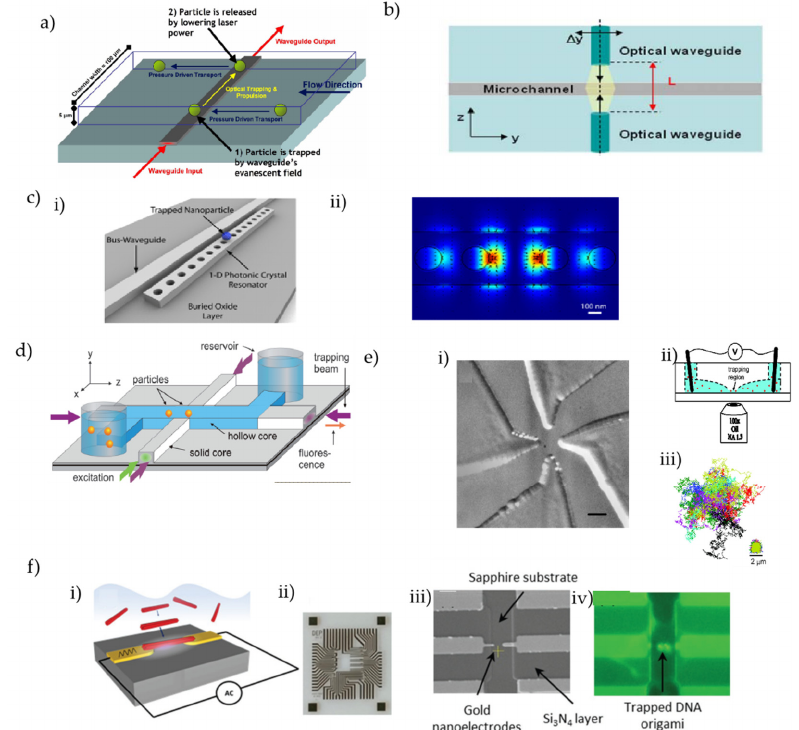
Figure 7. ( a ) Schematic of trapping experiment. The optical waveguide propulsion is perpendicular to the direction of the pressure-driven flow in the channel [333]. ( b ) Basic scheme of the optofluidic chip: the two waveguides emit counter-propagating Gaussian beams. The sample under testing flows into the microchannel [334]. ( c ) ( i ) 3D schematic of the one-dimensional photonic crystal resonator optical trapping architecture [337] ( ii ) 3D FEM simulation illustrating the strong field confinement and amplification within the one-dimensional resonator cavity [337]. ( d ) Schematic layout of optofluidic loss-based trapping and manipulation of particles, showing intersecting solid- and liquid-core ARROW waveguides and relevant optical beam paths [279]. ( e ) ( i ) Glass microfluidic cell for the ABEL trap with the trapping region showing the patterned glass cell [338]. ( ii ) The microfluidic cell sits above the oil-immersion objective of an inverted optical microscope capable of observing single molecules [338]. ( iii ) Trajectories of 13 trapped particles of TMV [338]. ( f ) Dielectrophoretic chip for trapping DNA origami [341]. ( i ) Device schematic structure of a dielectrophoresis chip on a sapphire substrate. Generated AC electric field in between gold nanoelectrodes absorbs DNA origamis to